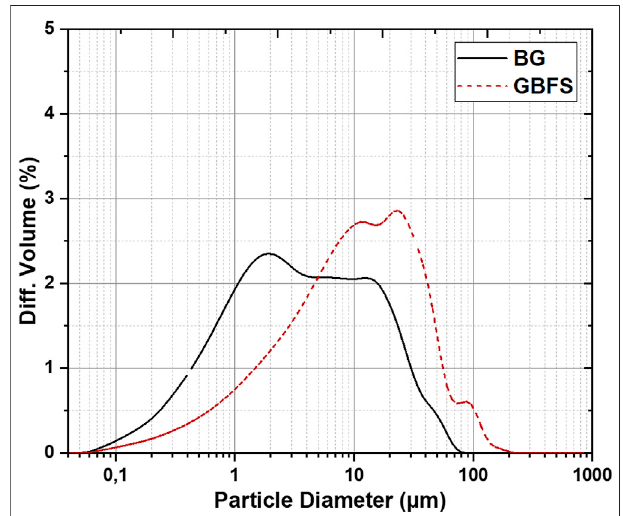
FIGURE 1 | Particle size distribution of the materials used in this study.